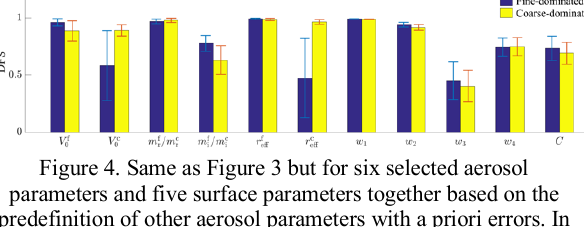
Figure 4. Same as Figure 3 but for six selected aerosol parameters and five surface parameters together based on the predefinition of other aerosol parameters with a priori errors. In which, the fine-mode 𝑚 mh and 𝑚 nh are selected for fine-dominated aerosols, while the coarse-mode 𝑚 mi and 𝑚 ni are selected for coarse-dominated